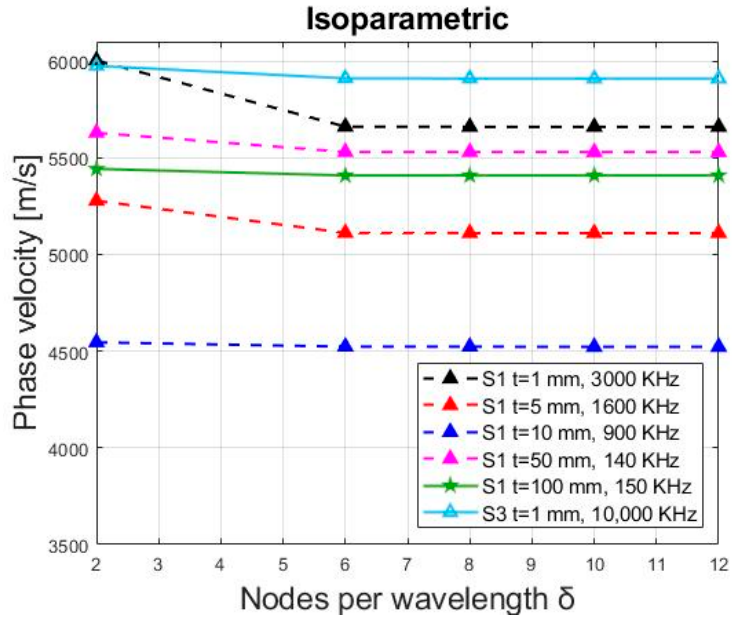
Figure 8. Number of nodes per wavelength required for convergence with plate thicknesses up to 100 mm.